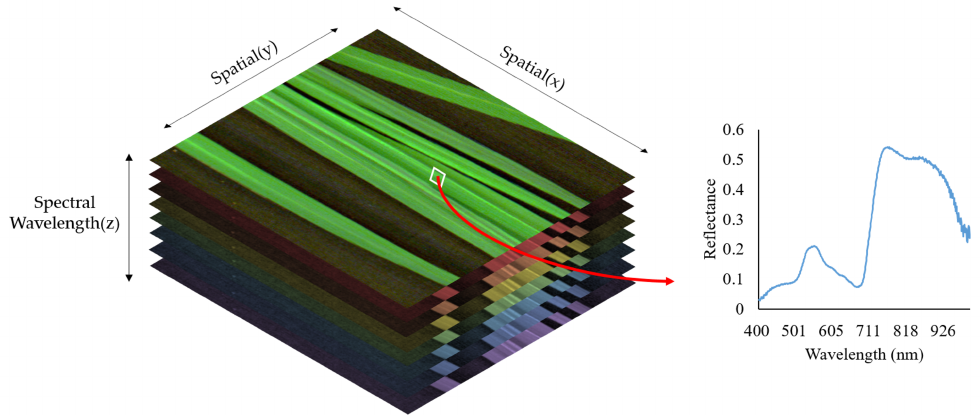
Figure 1. Two-dimensional projection of a hyperspectral